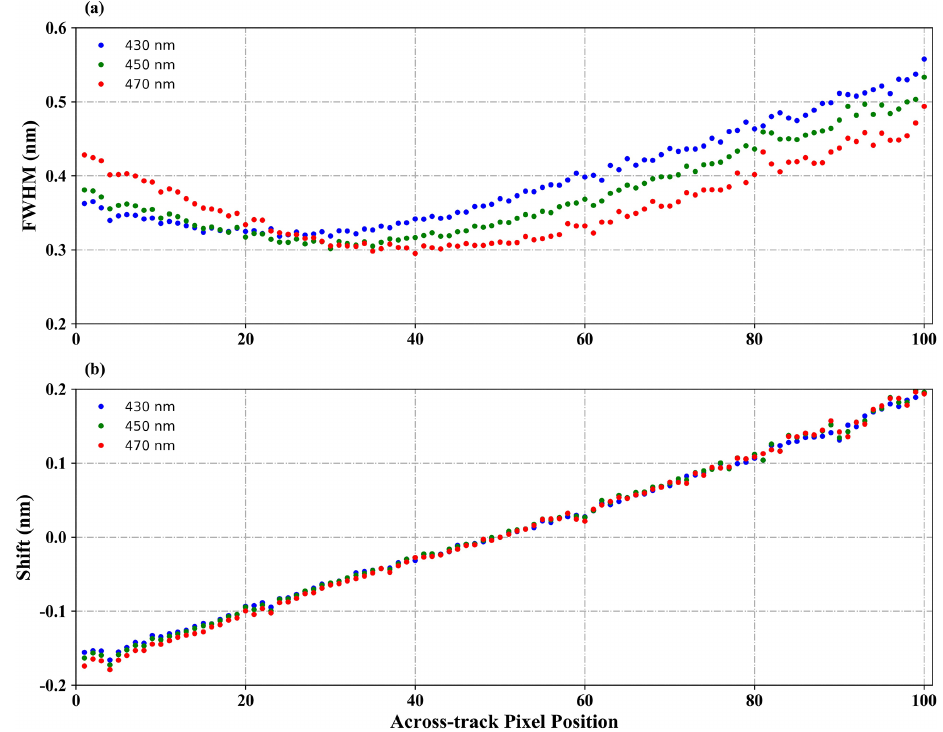
Figure 5. In-flight spectral calibration: (a) the spectral resolution (FWHM); (b) the spectral shift on different across-track positions. Results at three wavelengths are plotted: blue for 430nm, green for 450nm and red for